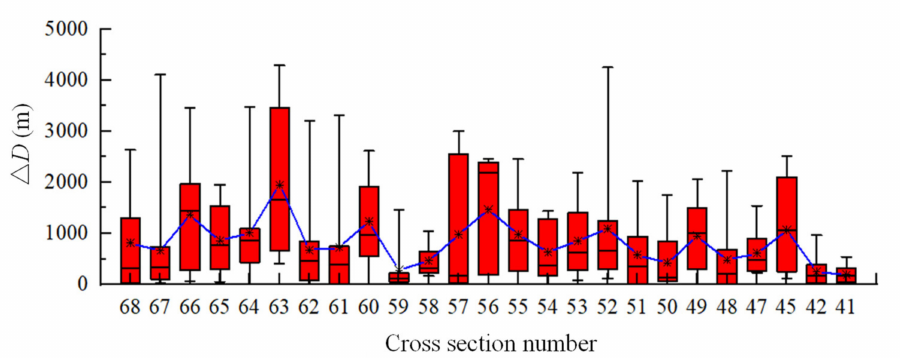
Figure 6. Spatial variations in section-scale thalweg migration distance along the Xiaobeiganliu